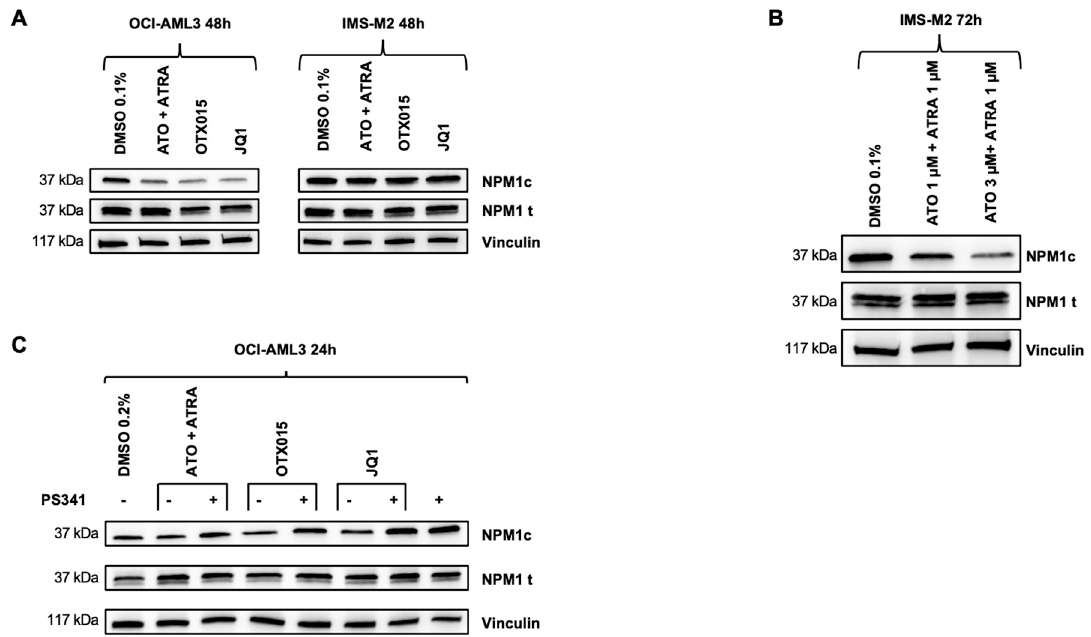
Figure 3. Effects of BETi on NPM1c/NPMwt protein expression. ( A ) OCI-AML3 cells were exposed 48 h either to 0.1% DMSO, 500 nM OTX015 (MK-8628), 500 nM JQ1, or 1000 nM ATO + 1000 nM ATRA. Western blot showing protein expression of NPM1c oncoprotein and total NPM1 by using appropriate antibodies were performed. Vinculin was used as loading control. One representative experiment out of three is shown. ( B ) IMS-M2 cells were exposed 72 h either to 0.1% DMSO, 1000 nM ATO + 1000 nM ATRA, or 3000 nM ATO + 1000 nM ATRA. Western blot showing protein expression of NPM1c oncoprotein and total NPM1 by using appropriate antibodies were performed. Vinculin was used as loading control. One representative experiment out of three is shown. ( C ) OCI-AML3 cells were exposed 24 h either to 0.2% DMSO, 500 nM OTX015 (MK-8628), 500 nM JQ1, or 1000 nM ATO + 1000 nM ATRA in the presence or absence of 10 nM of the proteasome inhibitor PS341 (bortezomib). Western blot showing protein changes of NPM1c oncoprotein and total NPM1 protein by using appropriate antibodies was performed. Vinculin was used as loading control. One representative experiment out of three is shown.